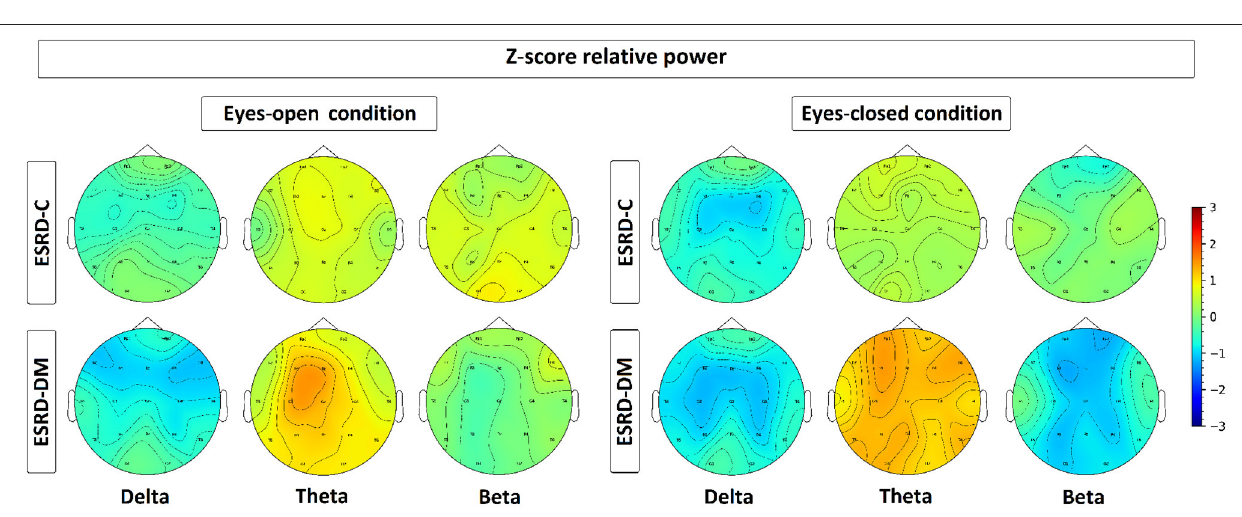
FIGURE 3 | Topographical map depicting the median of Z-score relative power, which is represented by colors varied from − 3.00 to 3.00. As seen, the relative power of ESRD-DM denotes high deviation from healthy control in delta, theta, and beta in both eyes-condition. In contrast, delta of ESRD-C in both eyes-condition show solely significant